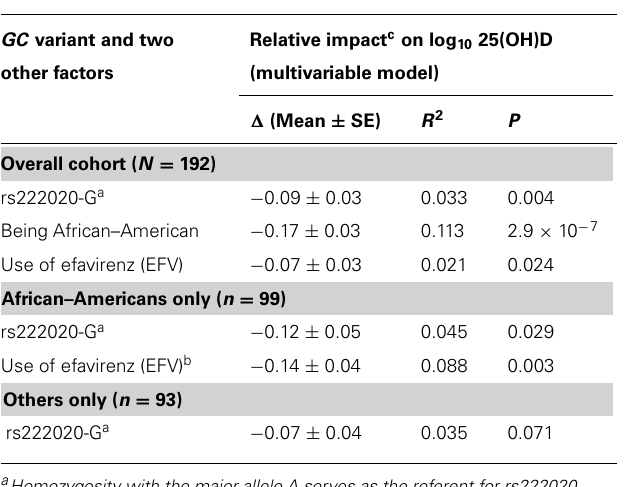
Table 7 | Examples of racial differences in genetic association with serum 25(OH)D concentration.